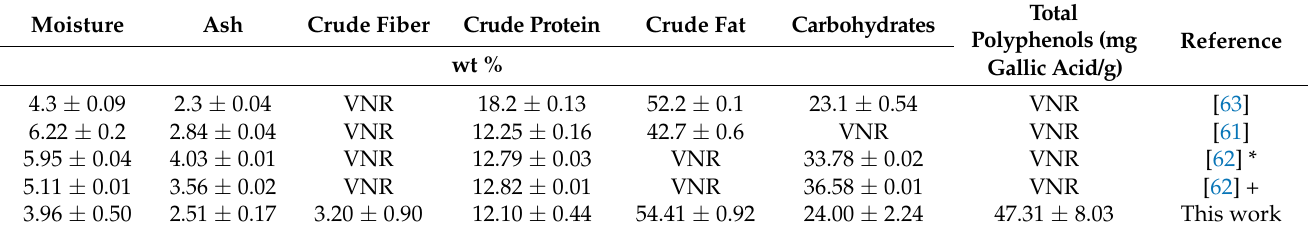
Table 4. Average proximate analysis for dried and fermented cacao beans (CB) from cacao fruit samples of various